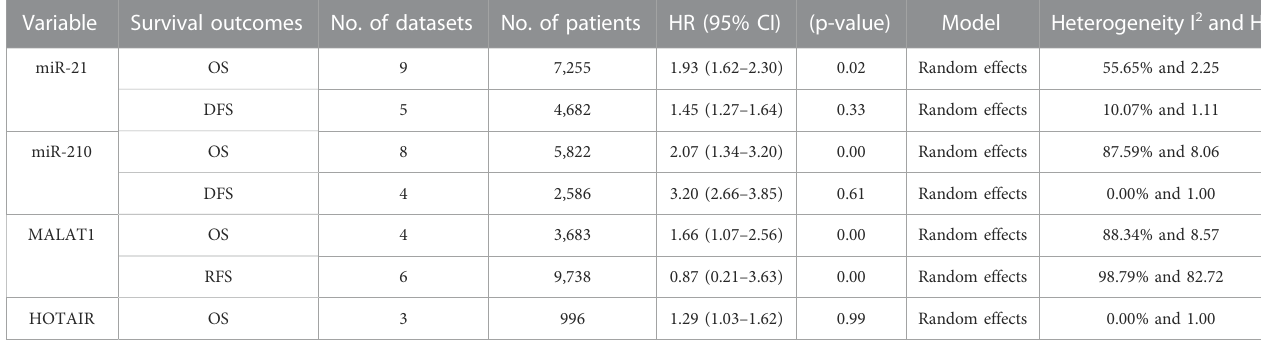
TABLE 3 Association of most frequently studied ncRNA expression with the survival rate. Variable Survival